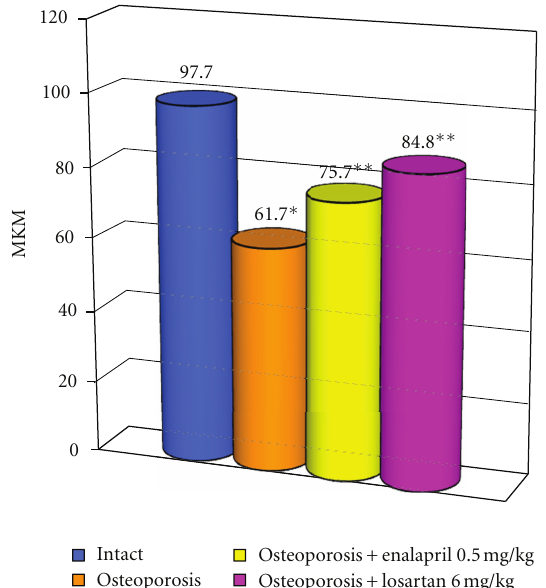
F 3: Effect of enalapril and losartan on the mean width of bone trabeculae in the proximal metaphysis of the femur aer eight weeks of bilateral ovariectomy.